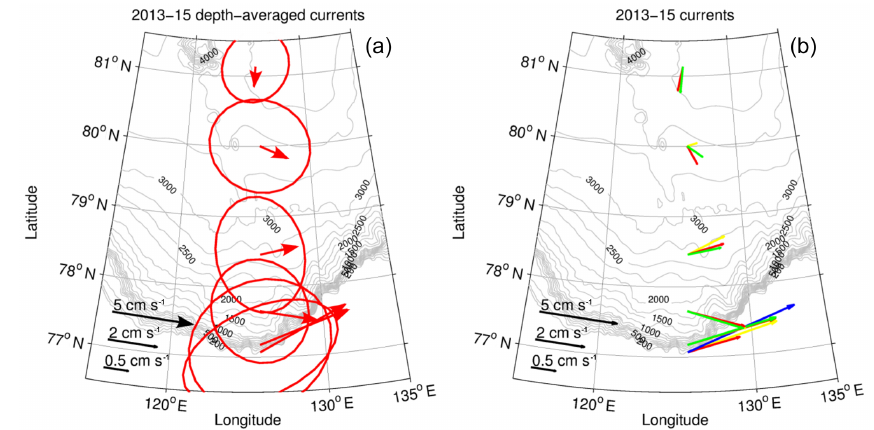
Figure 5. (b) The 2013–2015 mean current vectors at 150 (blue), 200 (yellow), 250 (red), and 300m (green), with (a) their depth-averaged (0–780m) means. Gray contours show isobaths. Red ellipses with the centers at mooring sites represent ellipses of the standard deviations of the depth-averaged currents. A nonlinear scale is used to show vectors and